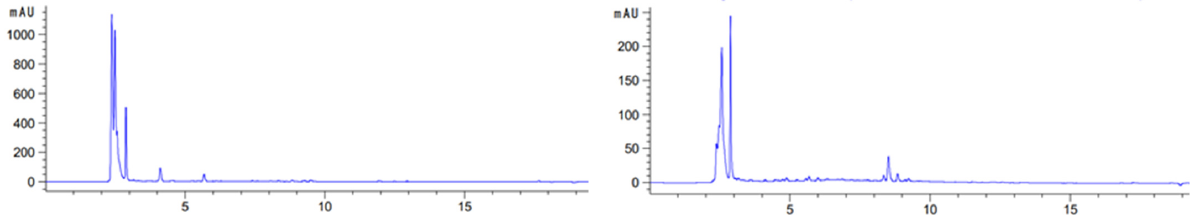
Figure 3. Polyphenolic profiles of steak meat product ( left ) and steak vegetarian product ( right ).